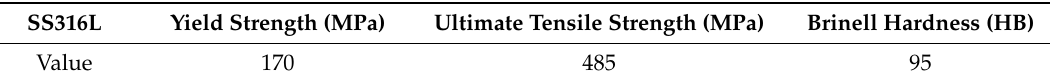
Table 3. Mechanical properties of SS316L.